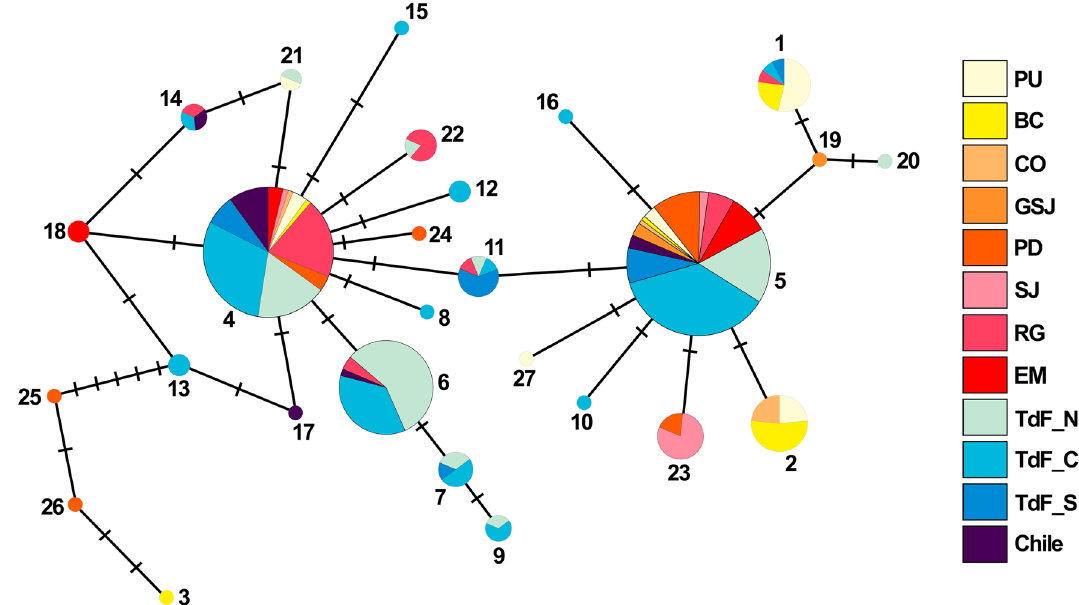
Figure 2. Haplotype network of Cephalorhynchus commersonii mitochondrial DNA control region sequences built using the median-joining algorithm (N = 308, 423 bp). The size of the circles is proportional to haplotype frequency, and the dashes between them represent one mutational step away from the next. PU = Playa Unión, BC = Bahía Camarones, CO = Caleta Olivia, GSJ = Golfo San José, PD = Puerto Deseado, SJ = San Julián, RG = Río Gallegos, SM = Strait of Magellan, TdF = Tierra del